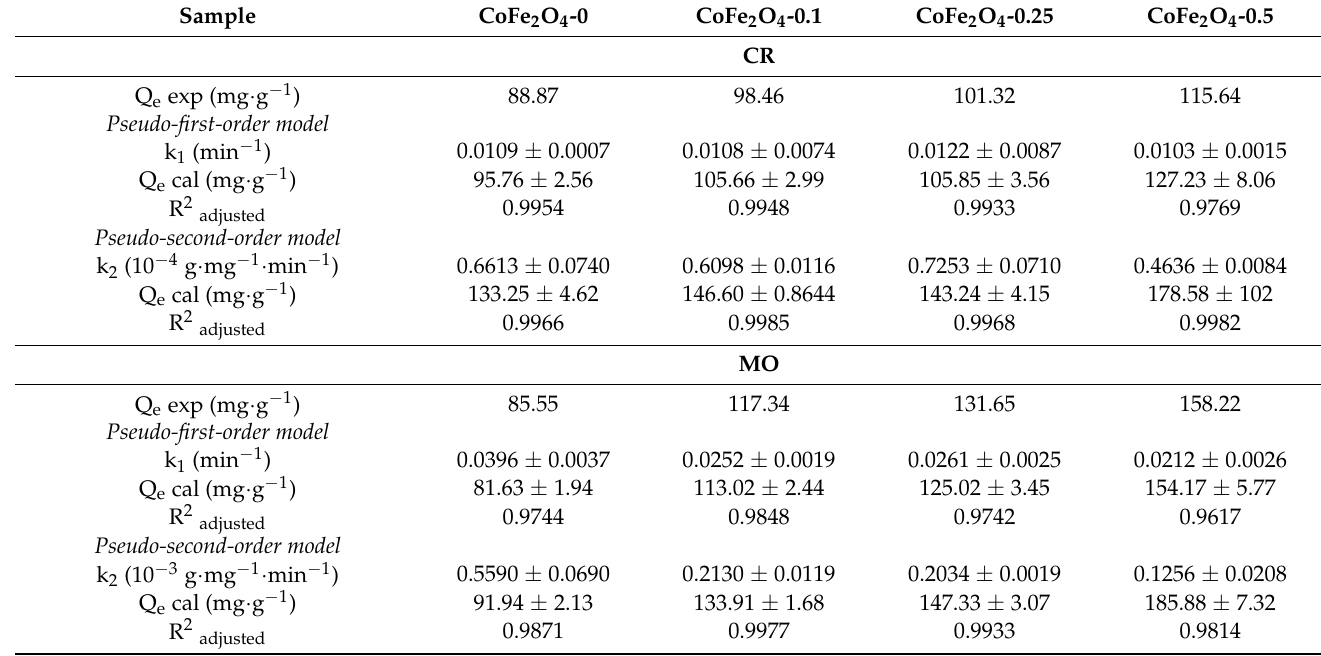
Table 4. The kinetic parameters for dyes adsorption onto CoFe 2 O 4 samples from binary solutions (nonlinear